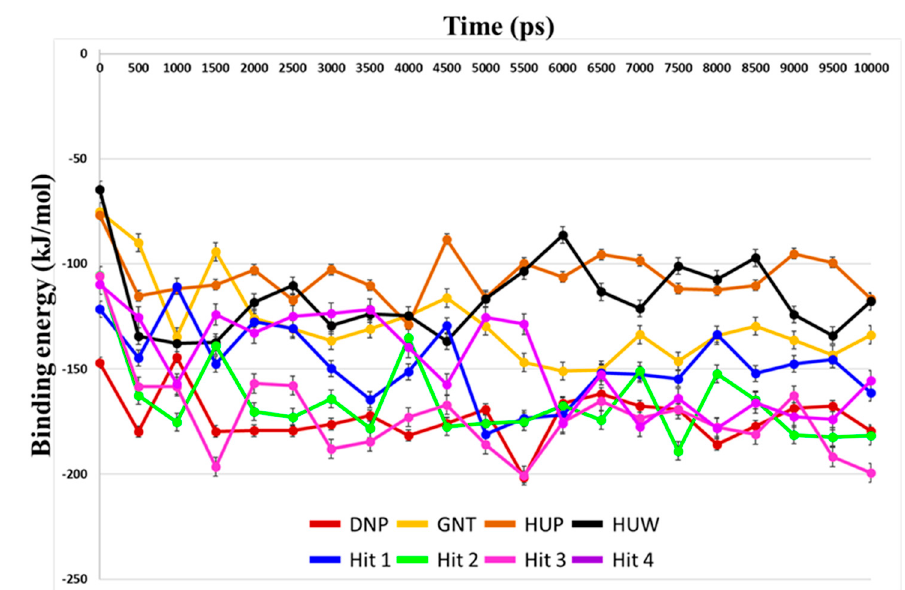
Figure 9. Prediction of binding free energies by MM-PBSA calculation. Binding free energy between hAChE and each reference and hit compounds was calculated using MD trajectories. Energy values for DNP, GNT, HUP, HUW, Hit 1, Hit 2, Hit3, and Hit4 are shown as red, yellow, brown, black, blue, green, magenta, and purple lines, respectively.